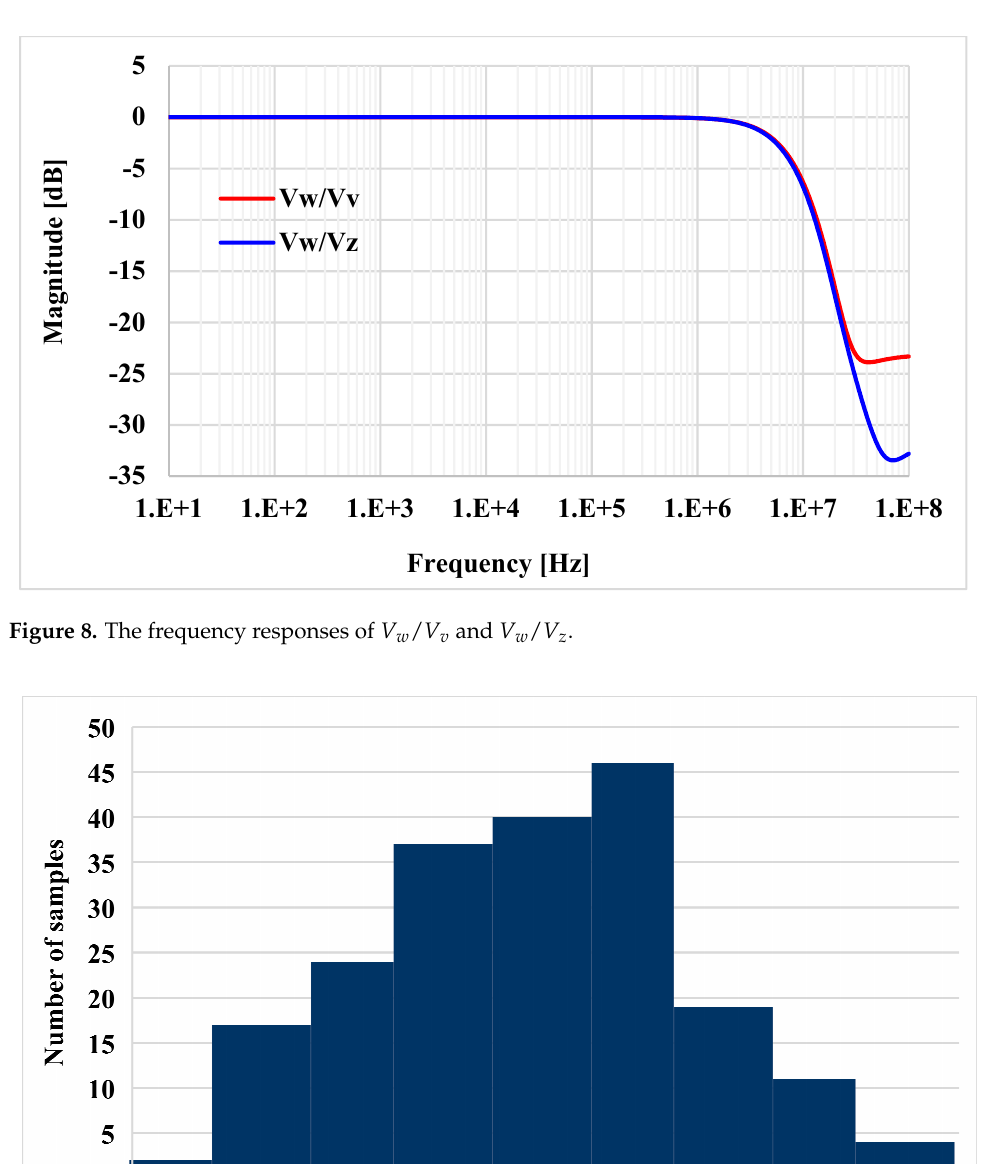
Figure 7. The output voltage V W versus the input voltage V v for different V z .